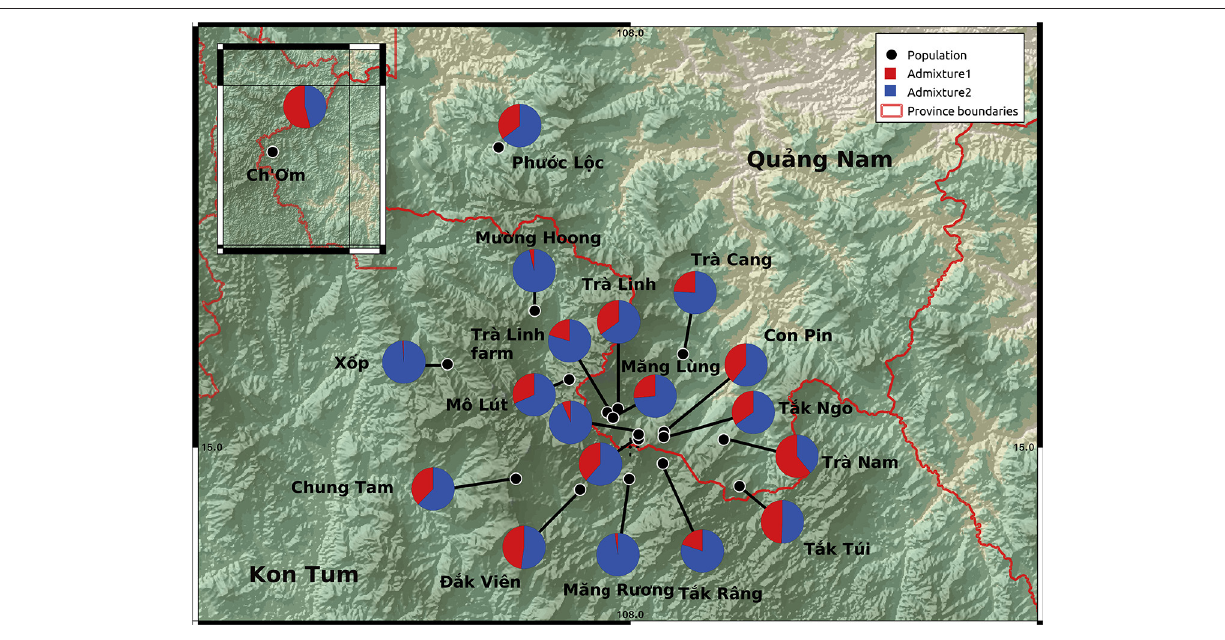
FIGURE 4 | Map showing Panax vietnamensis population sampling locations with average admixture plots K = 2. No consistent differences in the admixture patterns were detected between